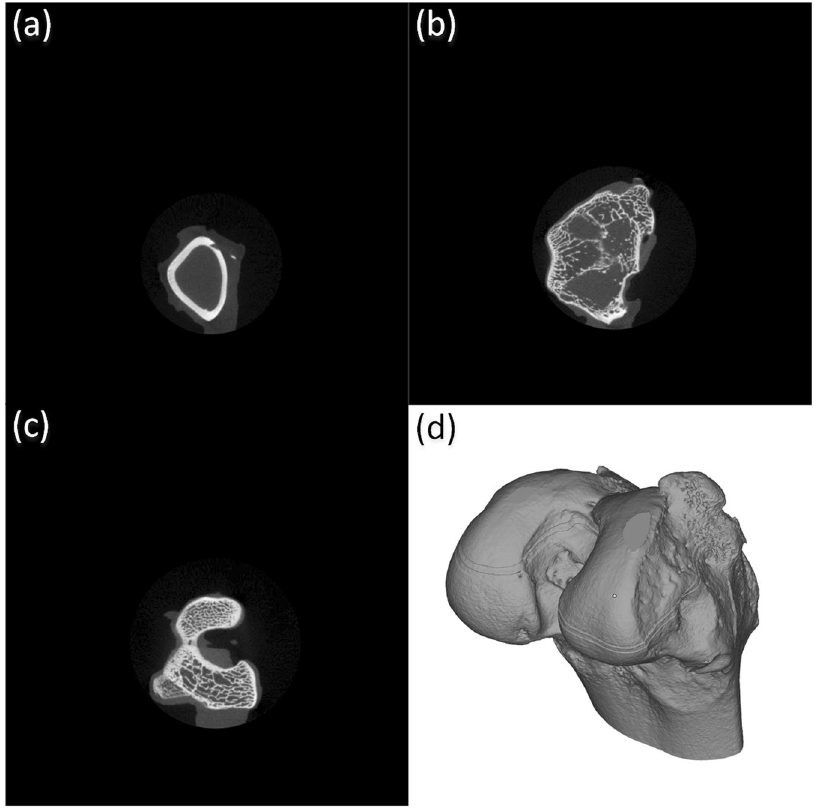
Figure 1. 3D reconstruction of the femoral condyle bone of a New Zealand rabbit by CT images, ( a ) CT image of the 106 th layer, ( b ) CT image of the 216 th layer, ( c ) the image of the 406 th layer, ( d ) femoral condyle bone as modeled by CT images.